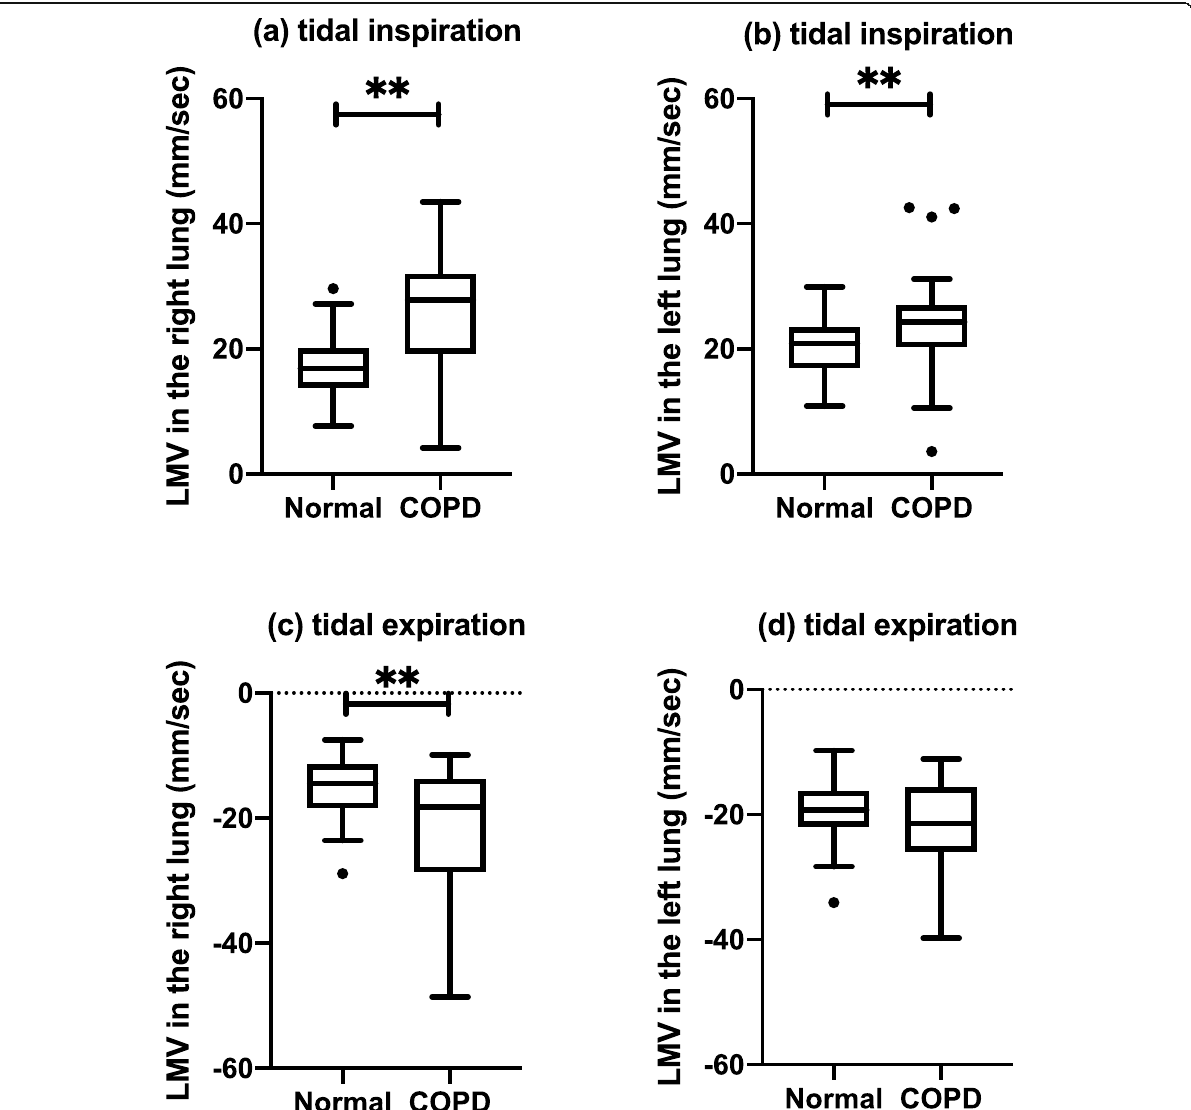
Fig. 7 Box-and-whisker plots of bilateral LMV of normal and COPD groups in tidal respiration. The lung parenchyma moved faster in COPD patients compared with normal subjects in the tidal respiration in both lungs except for the tidal expiration in the left lung. ** p < 0.01. COPD Chronic obstructive pulmonary disease, LMV Lung motion